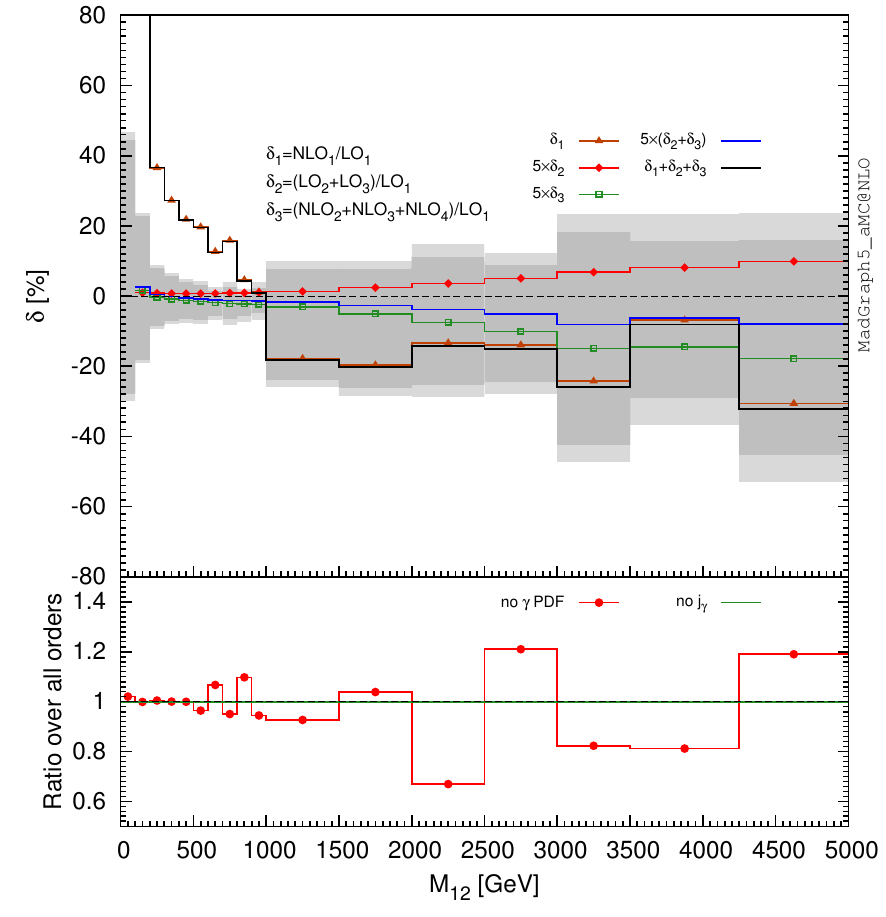
Figure 12 . Invariant mass of the hardest jet